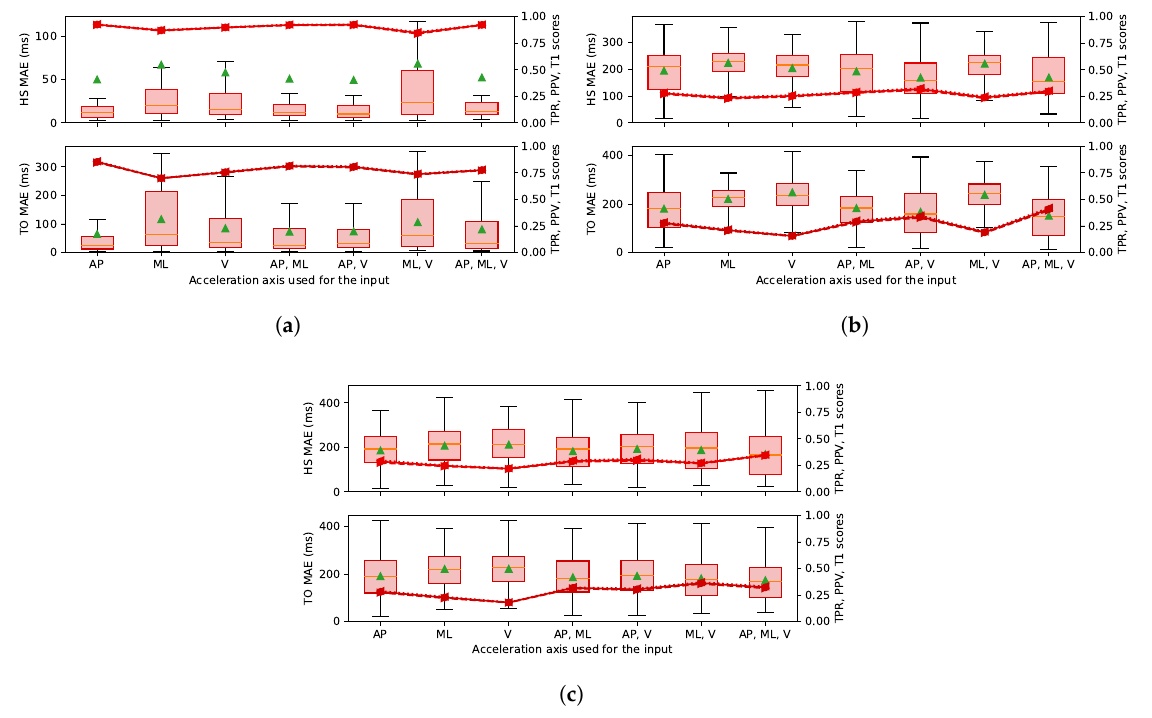
Figure 10. MAREA database results of MAE, TPV, PPV and T1 performance of the ESN for GED on subset MAR all . The boxplots are related to the left axis and represent the MAE distribution over all the timeseries of the testing set. The lines, relative to the right axis, represent the value of the TPV, PPV and T1 score. The horizontal axis categories are relative to different input axis combinaisons. Each vertically aligned subplot represents the results for one event class. The three subfigures represent the result from different IMU positions. ( a ) Foot sensor position; ( b ) wrist sensor position; ( c ) waist sensor position.